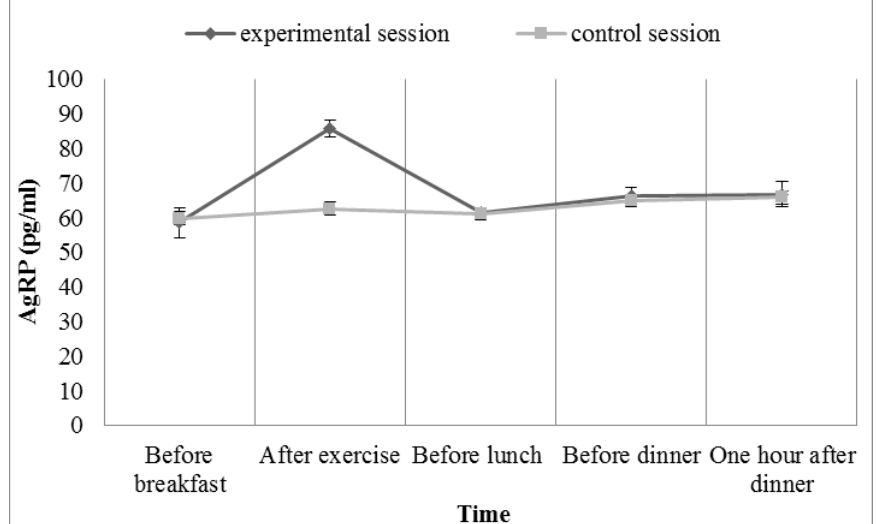
Figure 1. Plasma concentration of AgRP in the control and experimental session. Values are mean±SD